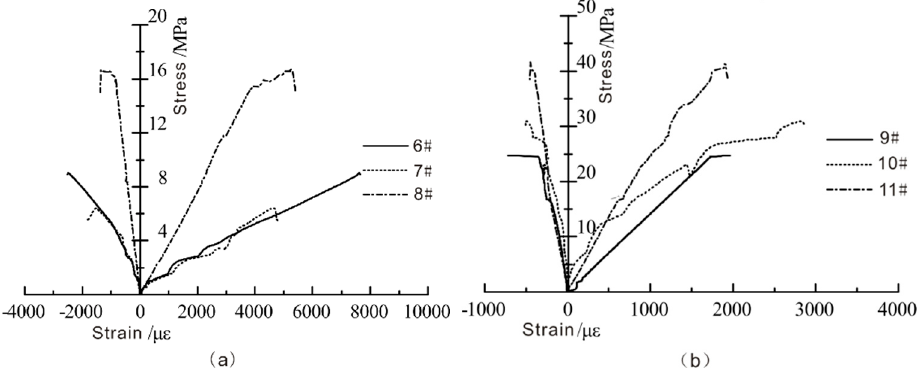
Figure 8. Stress-strain curve of marine shales under uniaxial compression test: ( a ) Carbonaceous shales at Changde; ( b ) Siliceous shales at Chande.